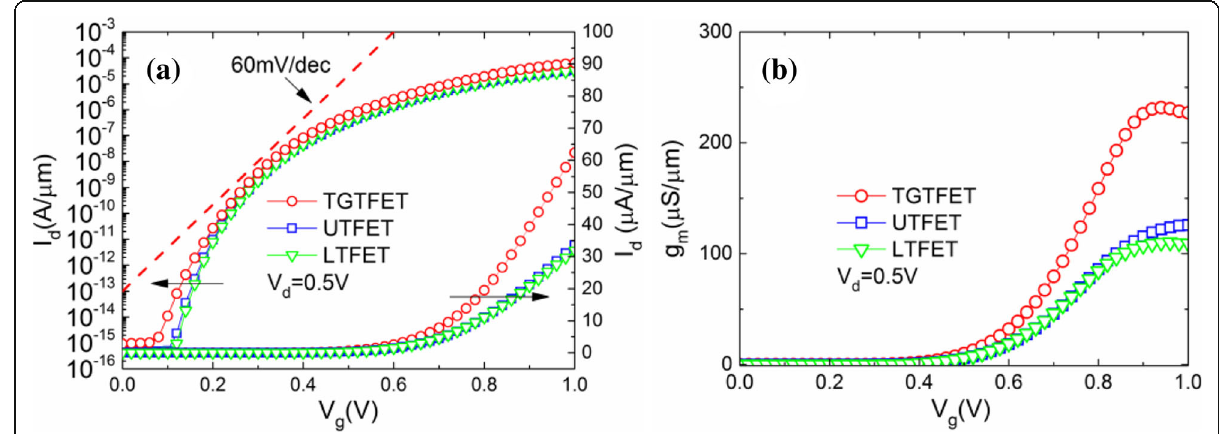
Fig. 10 a Transfer characteristics and b transconductance curves of TGTFET, UTFET, and LTFET at V d = 0.5